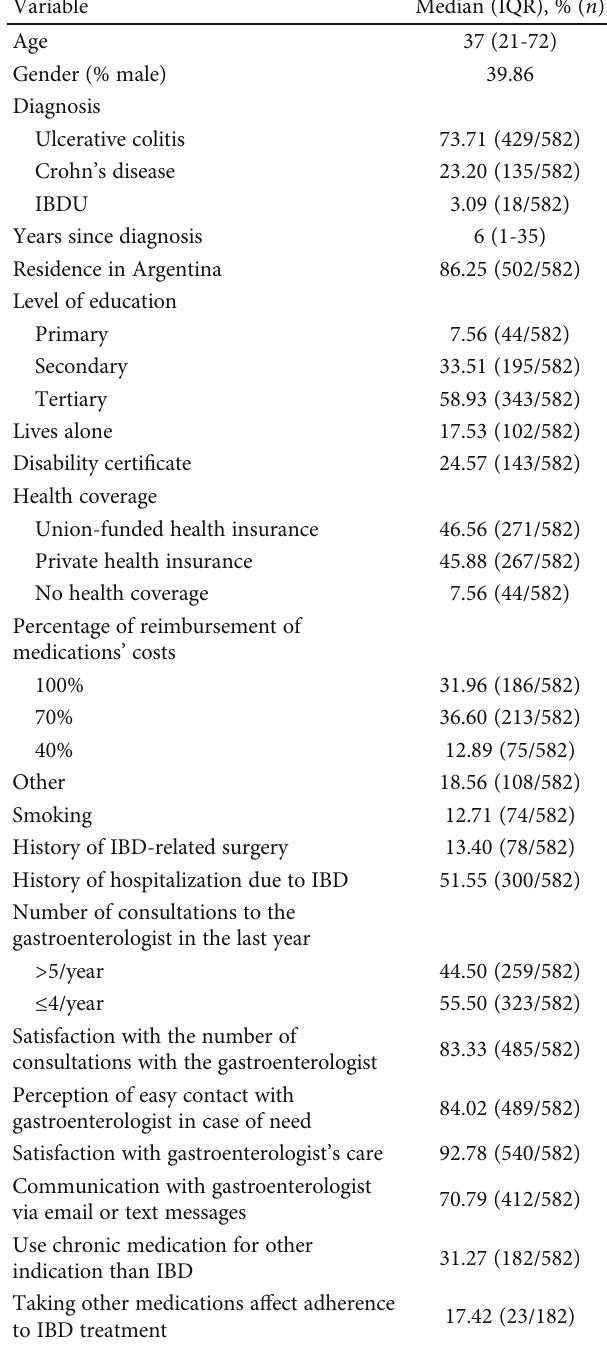
Table 1: Characteristics of